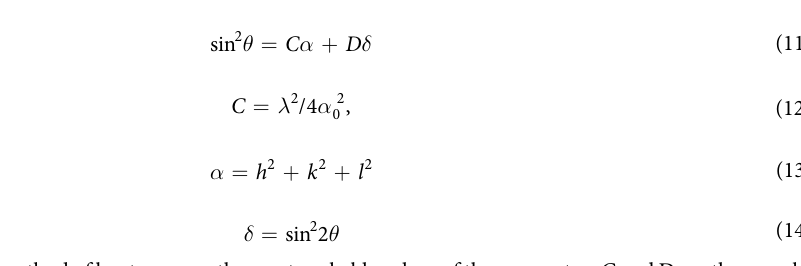
According to the method of least squares, the most probable values of the parameters C and D are those make the sum of squares